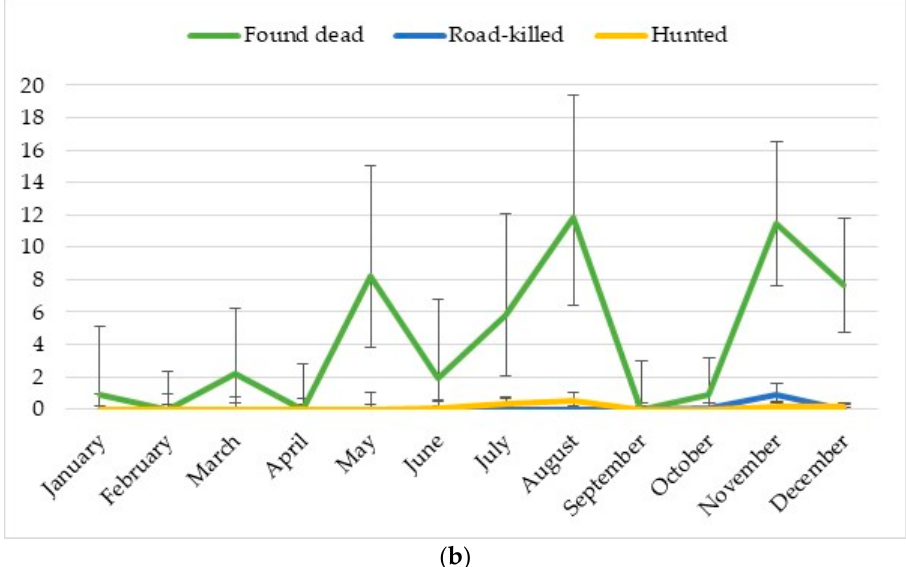
Figure 1. Monthly distribution of ASF-positive results (%) in different zones: ( a ) Part II-III; ( b ) Part I-0.